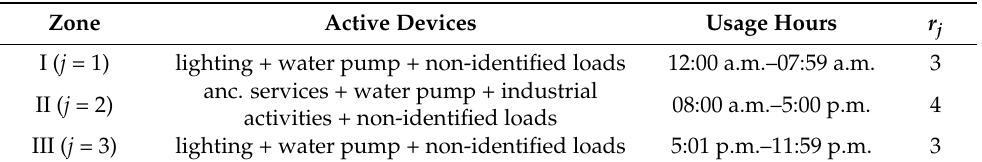
Figure 3. A working day is divided into three operating zones according to patterns of energy use. Table 1. Active devices in each